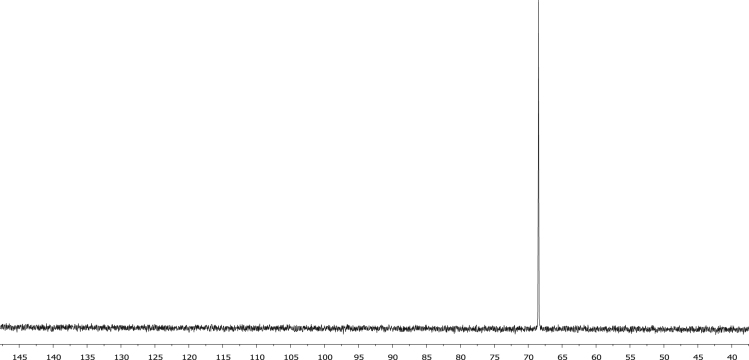
31P NMR of diphenylphosphino amide C6H5NHPPh2, 3.